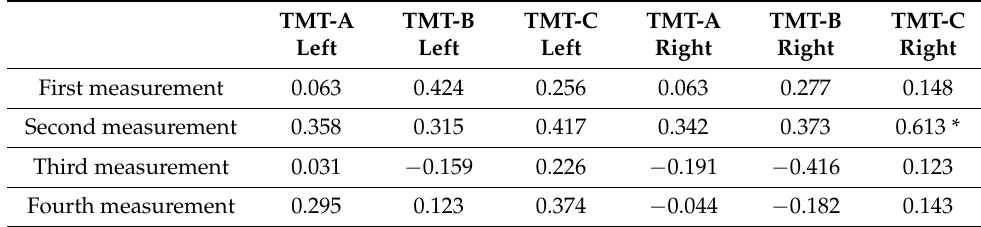
Table 2. Correlation between changes in hemoglobin concentration and amylase levels.